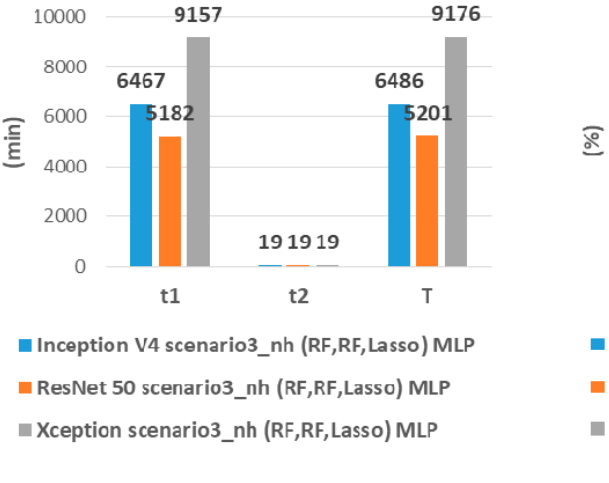
Figure 8. ( a ) Training data collection time t 1 , training time t 2 , and total time T of scenario 4-1, ( b ) For each CNN model, the highest processing prediction accuracy of scenario 4-1.